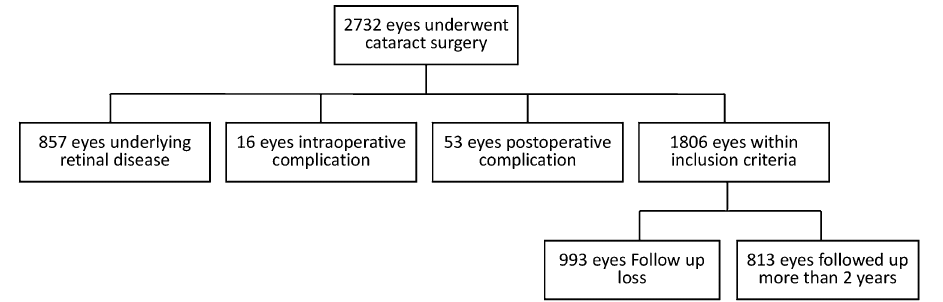
Figure 1. Flowchart illustrating the distribution of patients.